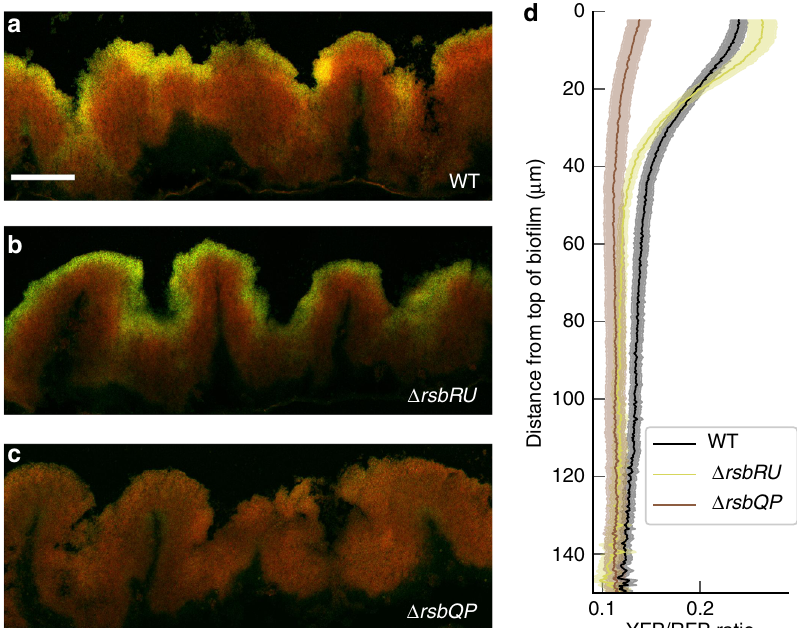
Fig. 2 The energy stress pathway mediates a σ B expression gradient from the top of the bio fi lm. a – c Confocal microscopy images of slices of central parts of 48 h bio fi lm colony with merged channels for constitutive fl uorescent reporter, P sigA -RFP, in red and P sigB -YFP in green. a WT cells, b Δ rsbRU cells, c Δ rsbQP cells. Scale bar 100 μ m. d The ratio of P sigB -YFP to P sigA -RFP expression levels in the three strains as measured from the top of the colony, error bars indicate the SEM (WT: n = 13 images from three experiments, Δ rsbRU : n = 10 from two experiments, Δ rsbQP : n = 11 from two experiments). Source data are provided as a Source Data fi